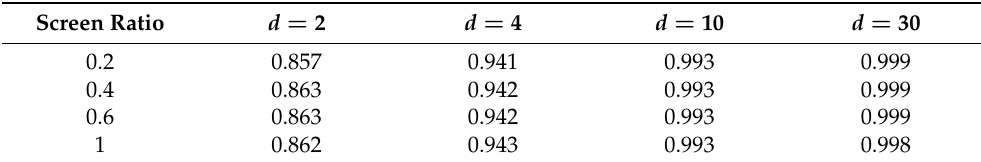
Table A1. Concordance between True Genoypes and Called Genotypes in Simulation. Average Sequencing Depth d = 2,4,10,30.